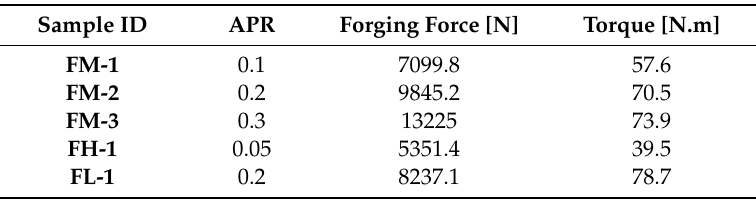
Table 3. Average measured tool forging force and torque, calculated heat input. APR: advance per revolution.